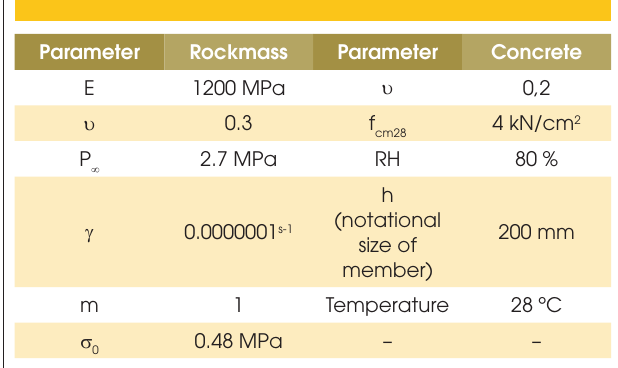
Table 3 – Rockmass and concrete properties of the experimental Kielder